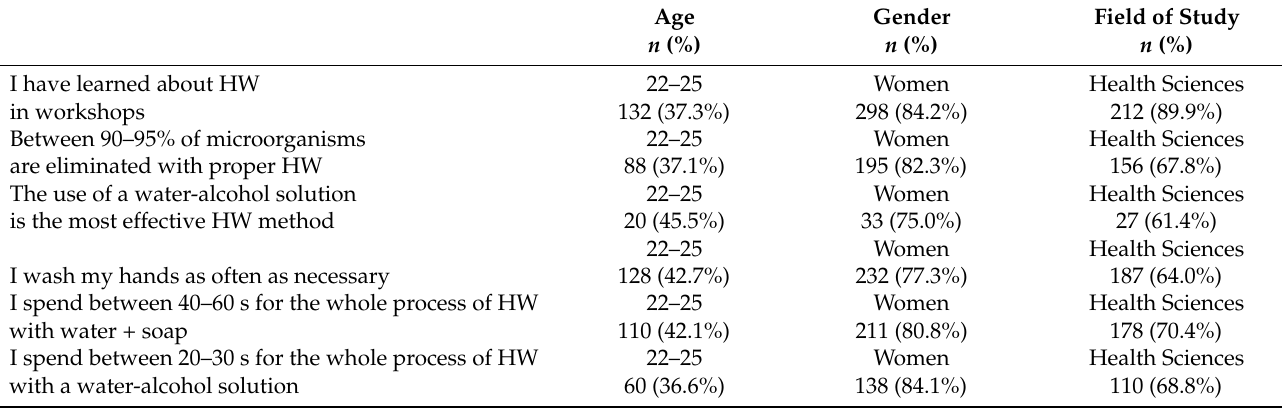
Table 8. Age group, gender and field of study acting as FACILITATORS for proper hand hygiene.